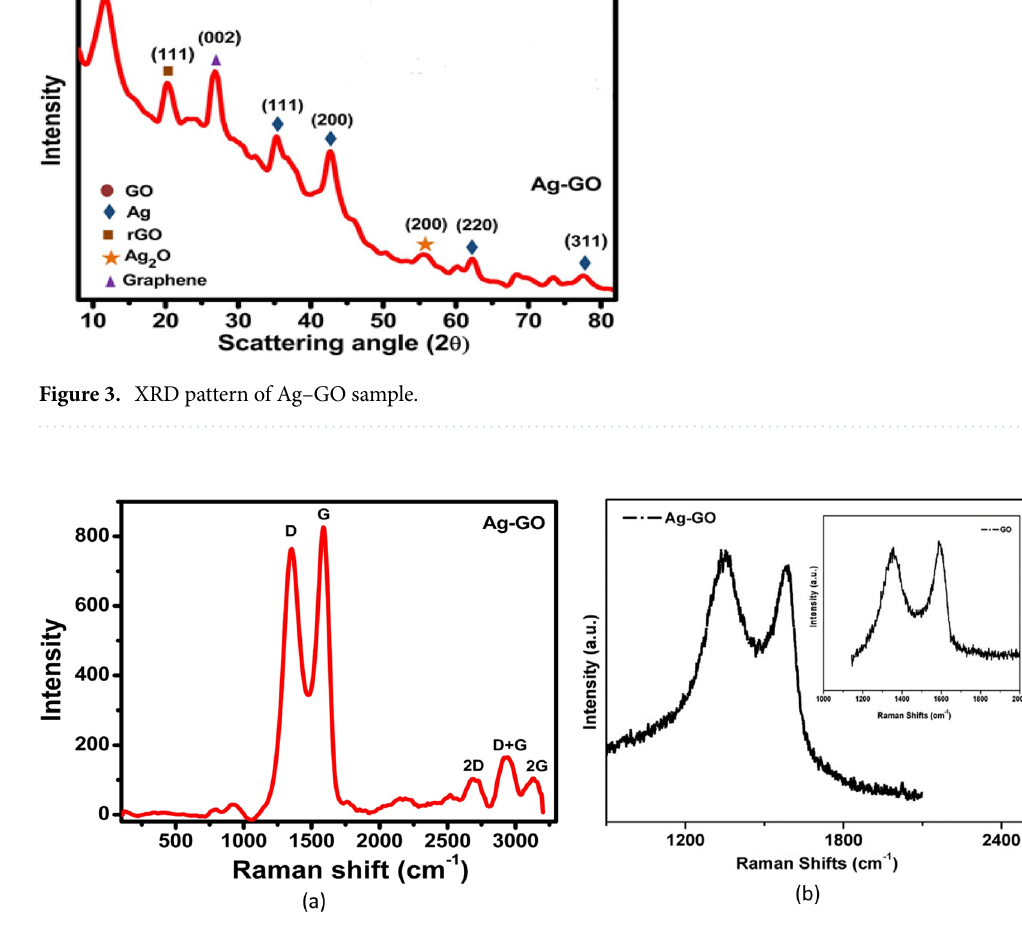
Figure 4. ( a ) Raman spectrum of Ag–GO sample ( b ) Raman spectra of GO and Ag–GO nanocomposite reported in reference 35